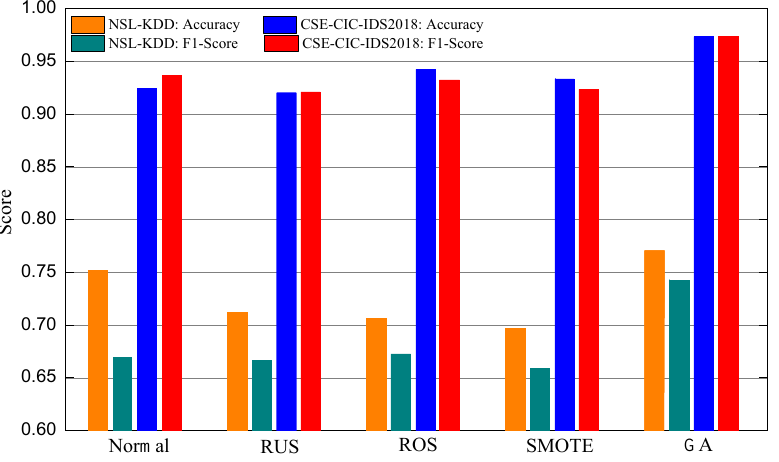
Figure 29. Comparison of different sampling techniques’ performance (using the F1-score and precision as the average of each